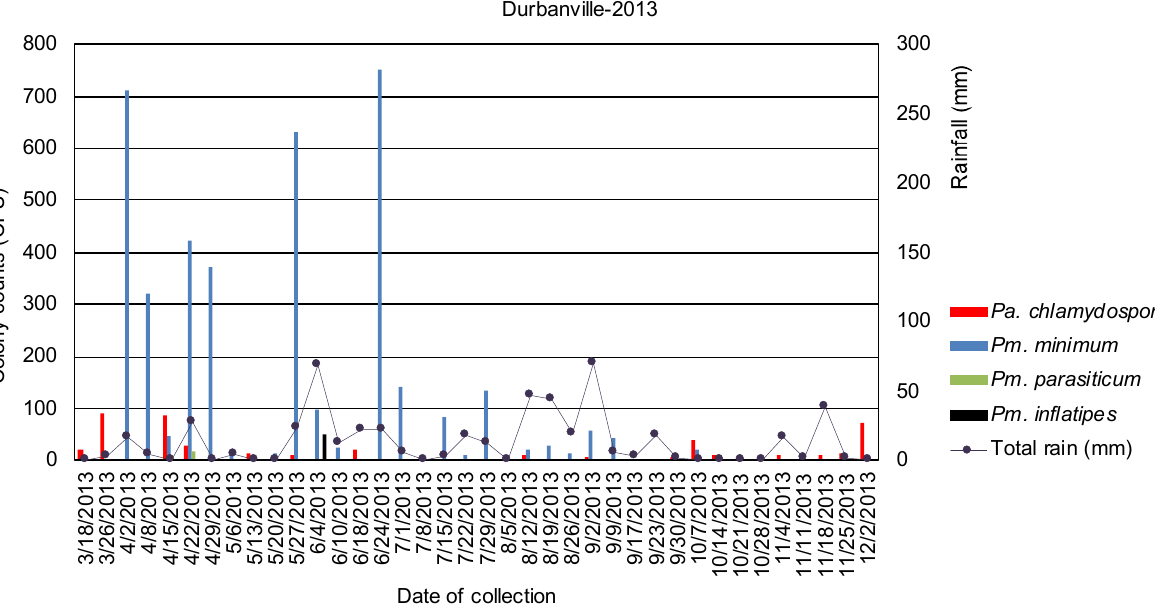
Figure 10. Phaeomoniella and Phaeoacremonium spp. cfu cultured from five vaseline coated microscope slides affixed to the cordons on each of five vines in a vineyard in Durbanville, Western Cape province in 2013. The slides were replaced weekly. Each bar represents the total number of cfu cultured on three Petri dishes.